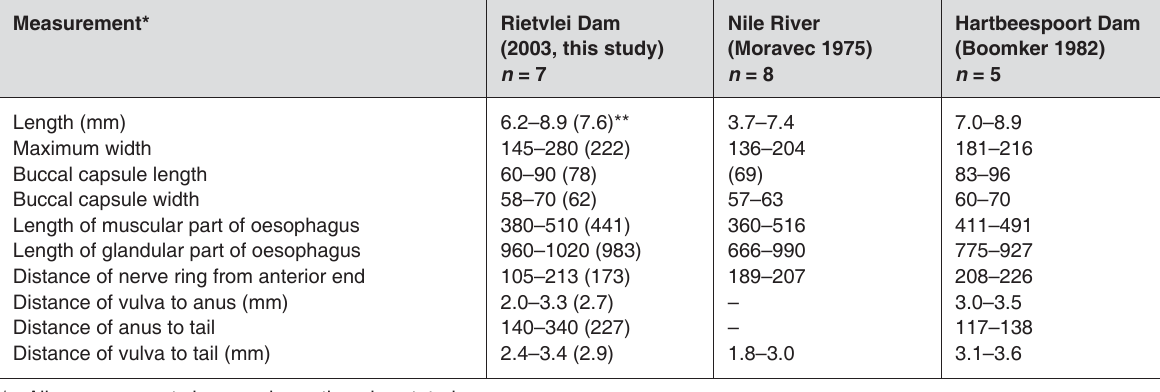
TABLE 1 Comparative diagnostic measurements of Procamallanus laevionchus infecting C. gariepinus from the Rietvlei Dam (this study) and Hartbeespoort Dam (Boomker 1982), and in Clarias sp. from the Nile River, Egypt (Moravec 1975)